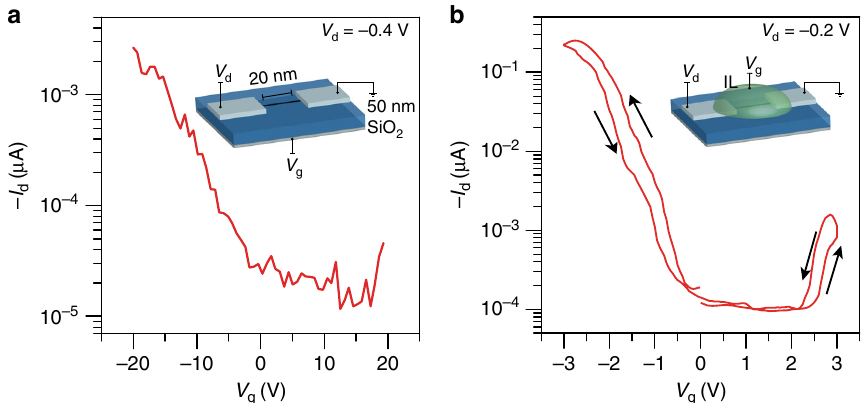
Fig. 4 Ionic liquid gating of a 9AGNRFET at room temperature. a I d − V g characteristics of the device gated by the thick 50 nm SiO 2 gate oxide. b I d − V g characteristics of the device gated with the ionic liquid which shows clear ambipolar behavior and improved on-state performance. Inset : ionic liquid (DEME-TFSI) gated 9AGNRFET device schematic